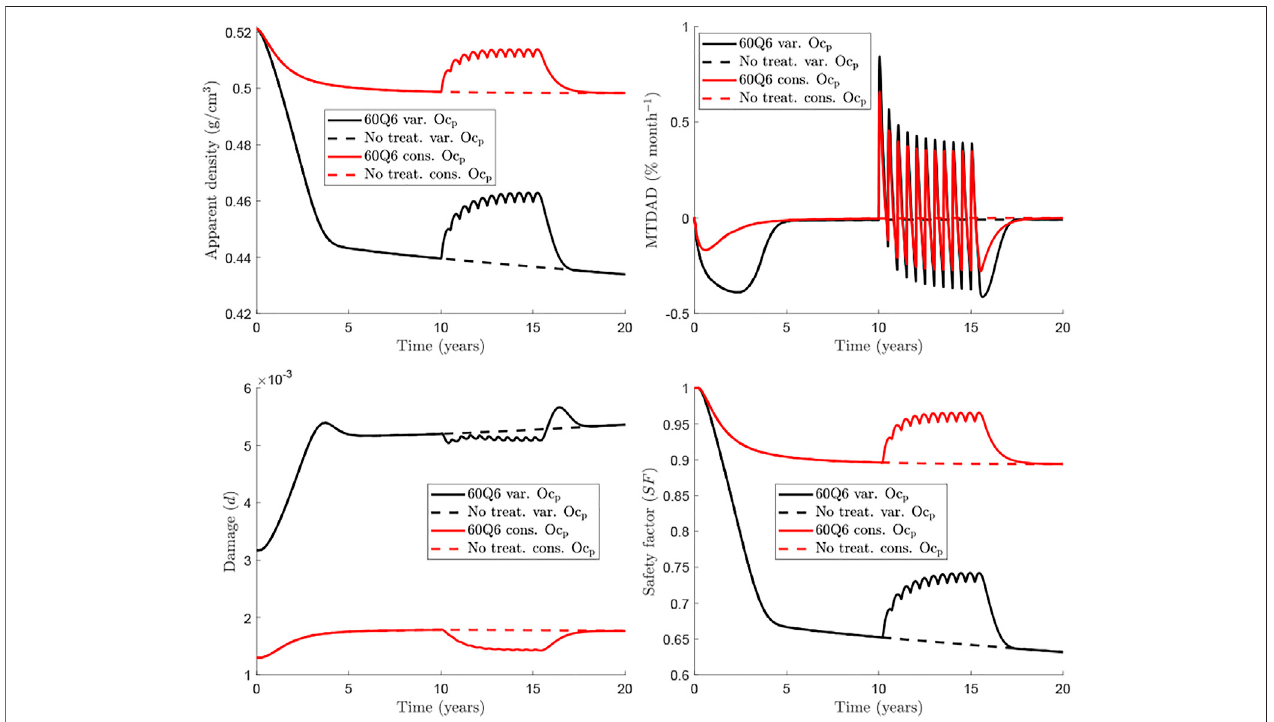
FIGURE 4 | Comparison of BCPM ext (black) and BCPM st (red) models for the femoral neck ( f bm =25%). The treatment 60Q6 (solid) is compared with the no treatment case (dashed) for each model. The evolution of apparent density (top left), MTDAD (top right), damage (bottom left) and safety factor (bottom right) are